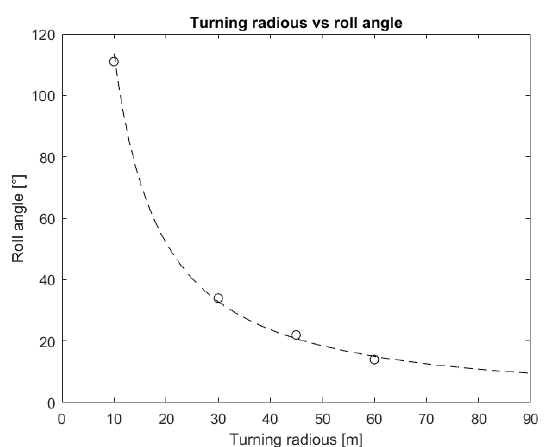
Figure 20. Turning radius vs. roll angle.